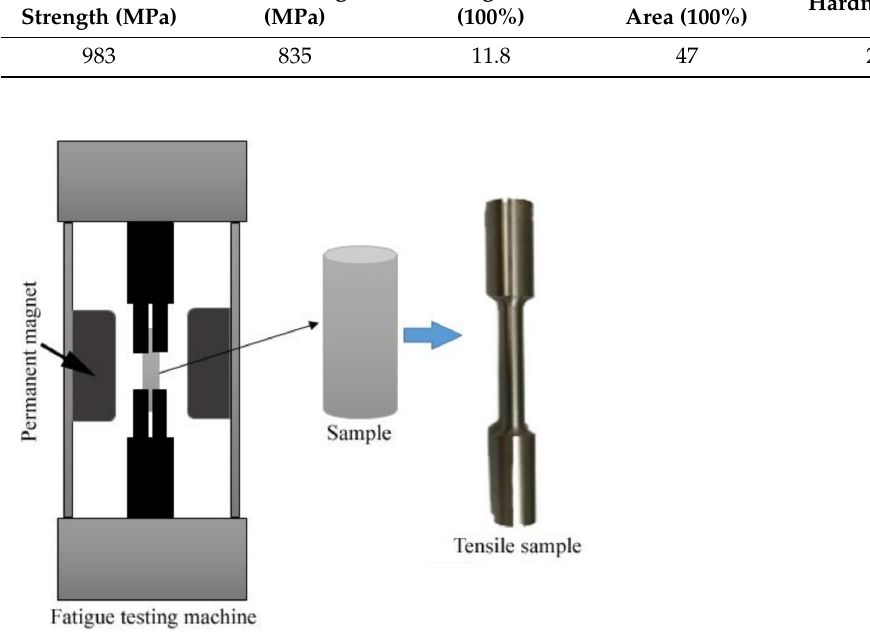
Figure 1. The illustration of fatigue tests containing magnetic field and the corresponding samples. The specimens of fatigue and mechanical experiments are cut into cylinders with dimension of Φ 5 mm × 10 mm, sanded and polished for microstructure